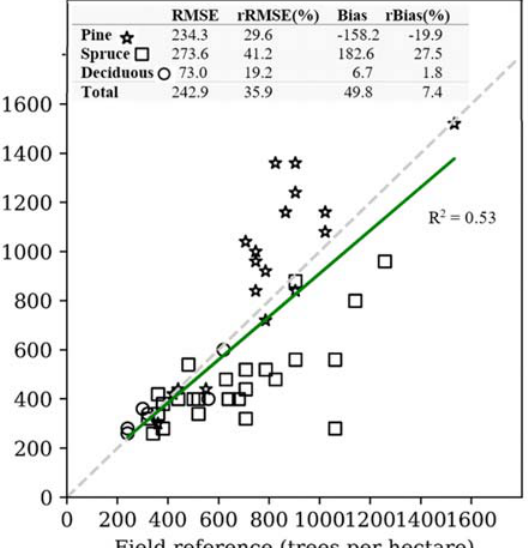
Figure 3. Tree density estimation (trees per hectare, TPH) using local maxima method with SPL data per each and all species classes.